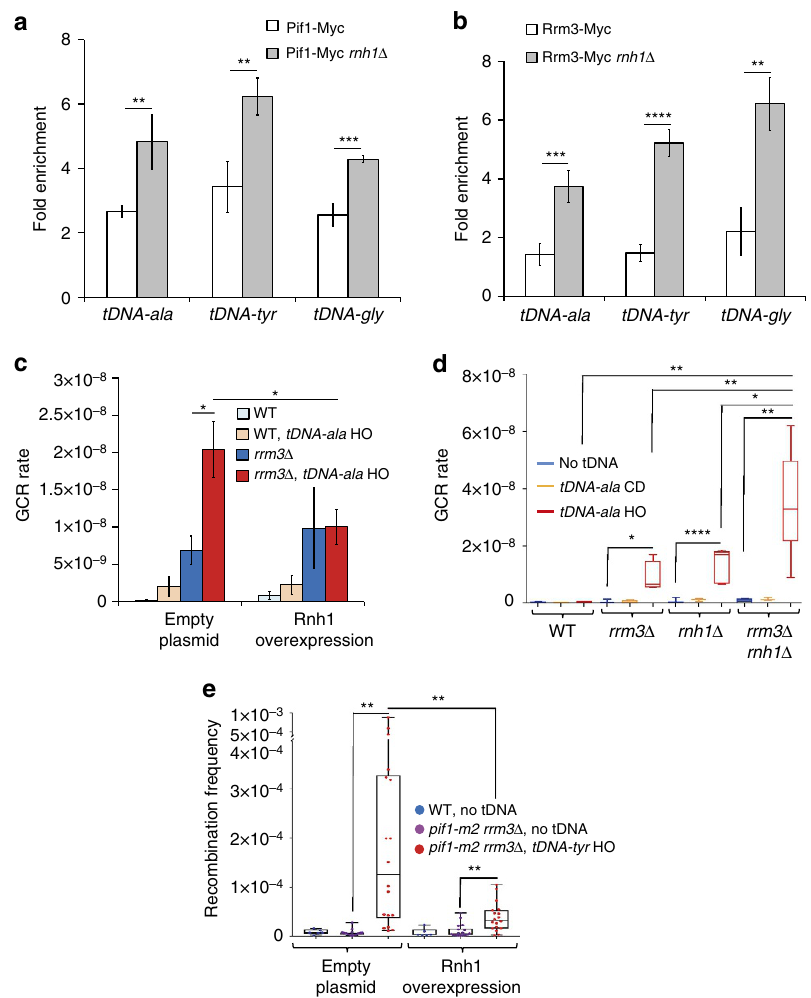
Figure 4 | tDNA-mediated damage in cells lacking Pif1 family helicases is due to R-loops. In each panel, data are from at least three independent technical and biological replicates per strain. ( a , b ) ChIP-qPCR analyses of Pif1-Myc and Rrm3-Myc binding to tDNA ala HO, tDNA tyr HO and tDNA gly HO in asynchronous WTand rnh1 D cells. Fold enrichment was calculated as in Fig. 1a,b. Error bars are ± s.d. for at least three independent experiments per strain. P -values here and elsewhere were obtained using unpaired two-tailed Student’s t -test. ( c ) Means of GCR rates ± s.d. in indicated strains. Cells carry either an empty or Rnh1 overexpression plasmid. ( d ) The distributions of events determined in the GCR assays in the indicated strains with or without tDNA ala inserts are presented in box-and-whisker plots. The means of the GCR rates with 95% confidence interval were calculated from at least three independent technical and biological replicates per strain. Means of GCR rates ± s.d. are also provided in Supplementary Table 1. ( e ) The recombination frequencies in the indicated strains with empty or Rnh1 overexpression plasmid are presented as box-and-whisker plots. The means of the recombination frequencies with 95% confidence interval were calculated from at least three independent technical and biological replicates per strain. Means of recombination frequencies ± s.d are presented in Supplementary Table 7. Here, * indicates P o 0.05, ** indicates P p 0.009, *** indicates P p 0.0009, and **** indicates P o 0.0001.